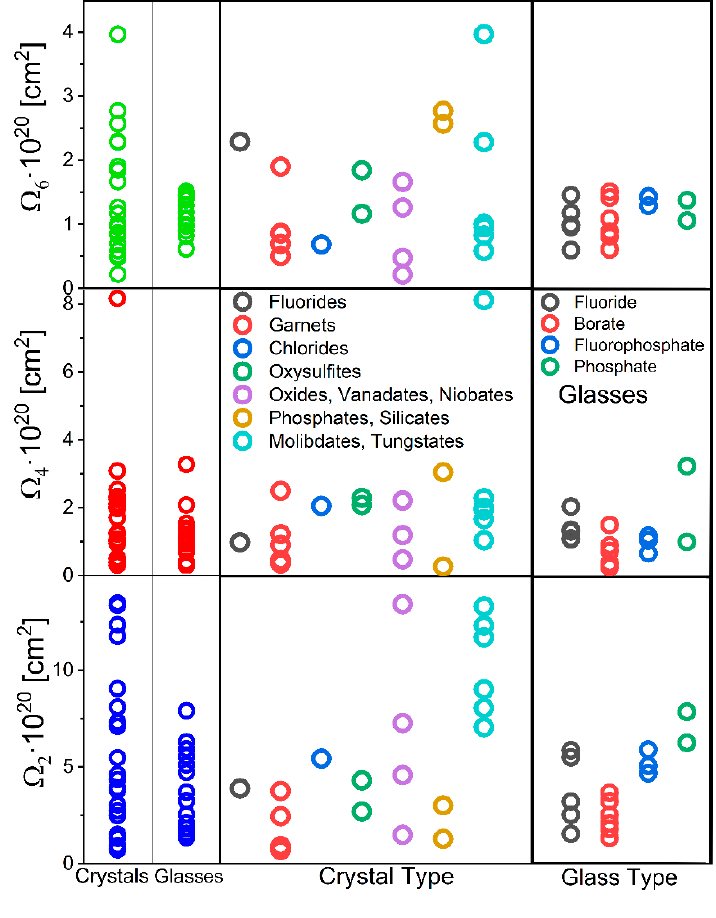
Figure 3. Judd–Ofelt parameters in different hosts, as given in Table 2.